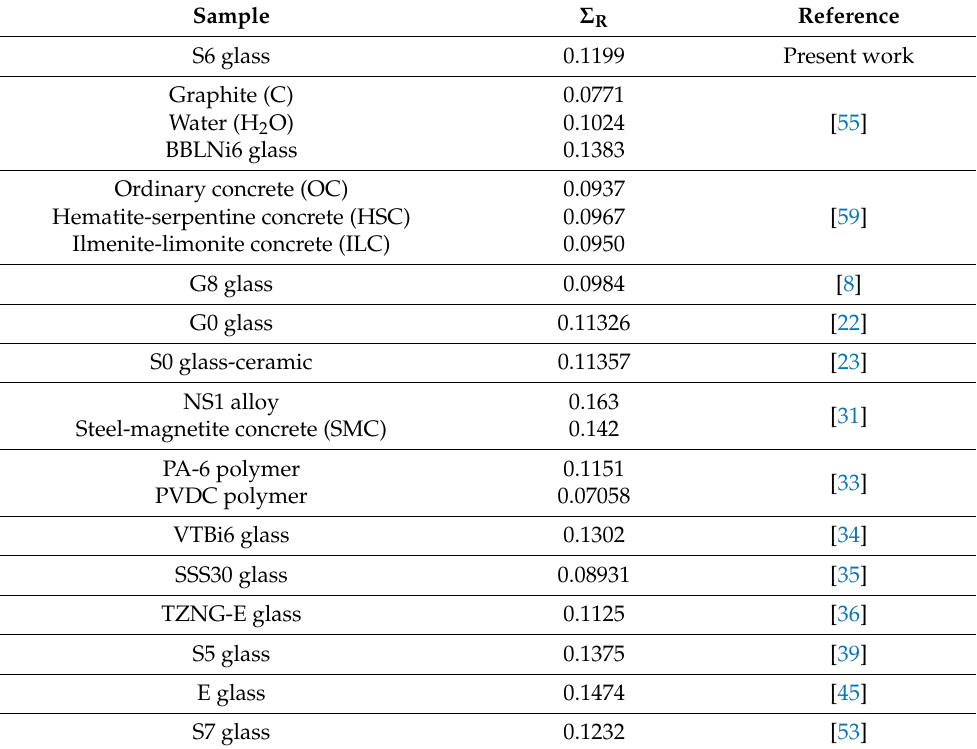
Table 3. Comparison of Σ R (cm − 1 ) of glass S6 with reported different nuclear radiation shielding ma-